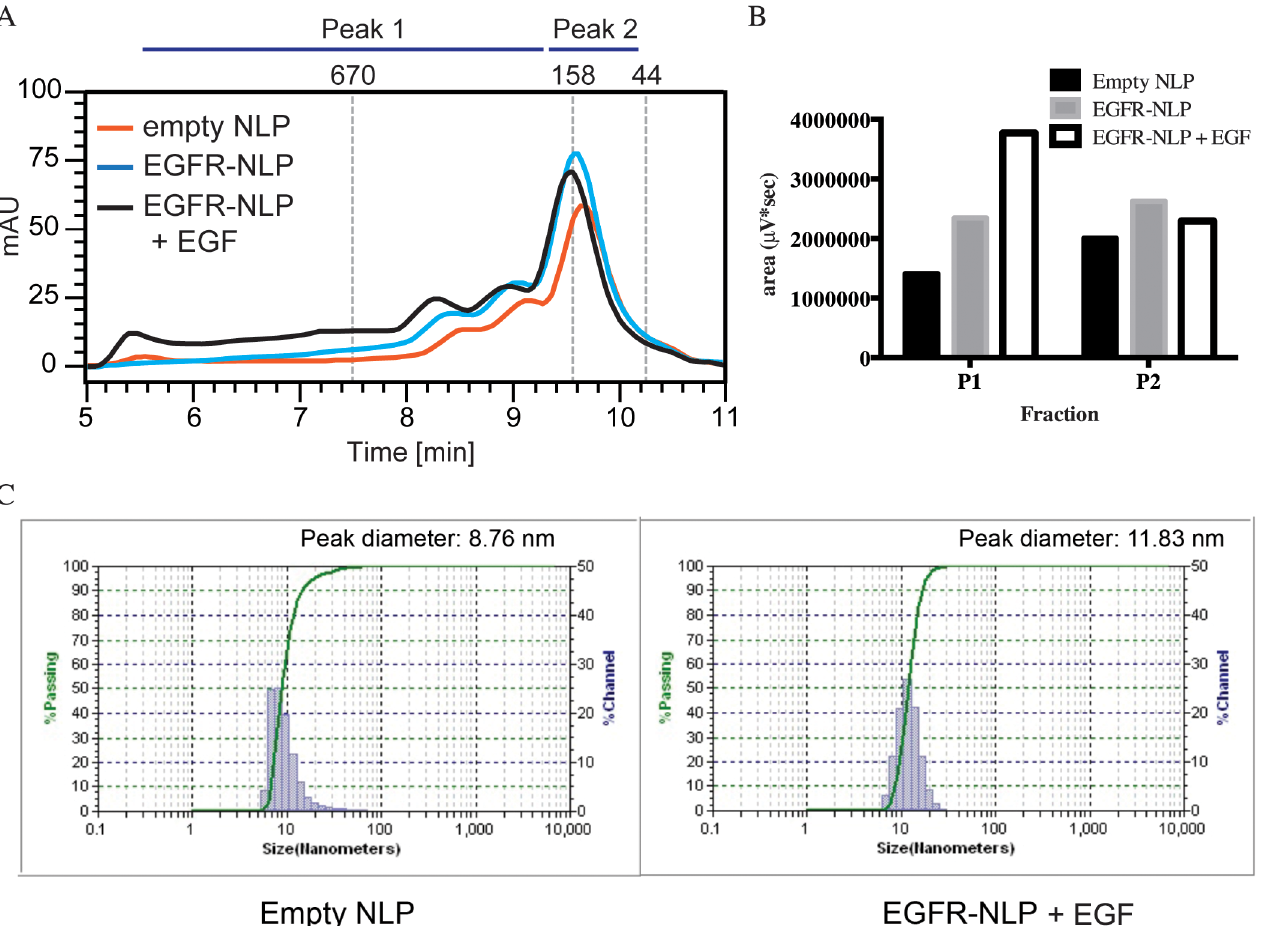
Fig 2. Characterization of EGFR-NLP size and shape. A , FollowingNLP self-assembly, the specified NLPs were separatedby a Yarra 3u SEC- 4000 column and typical traces are shown. Empty NLPs elute between9.5–10.5 minutes (P2) with EGFR-NLPs eluting earlierat 5.5–9.5 minutes (P1). Numbers aboveindicate molecularmass (in kDa) of known protein standards. B , Quantification of area under the curve of the P1 and P2 SEC peaks in μ V * secfrom a typical SEC trace. C , Empty and EGFR-NLPs were analyzedby DLS to determine NLP diameter.